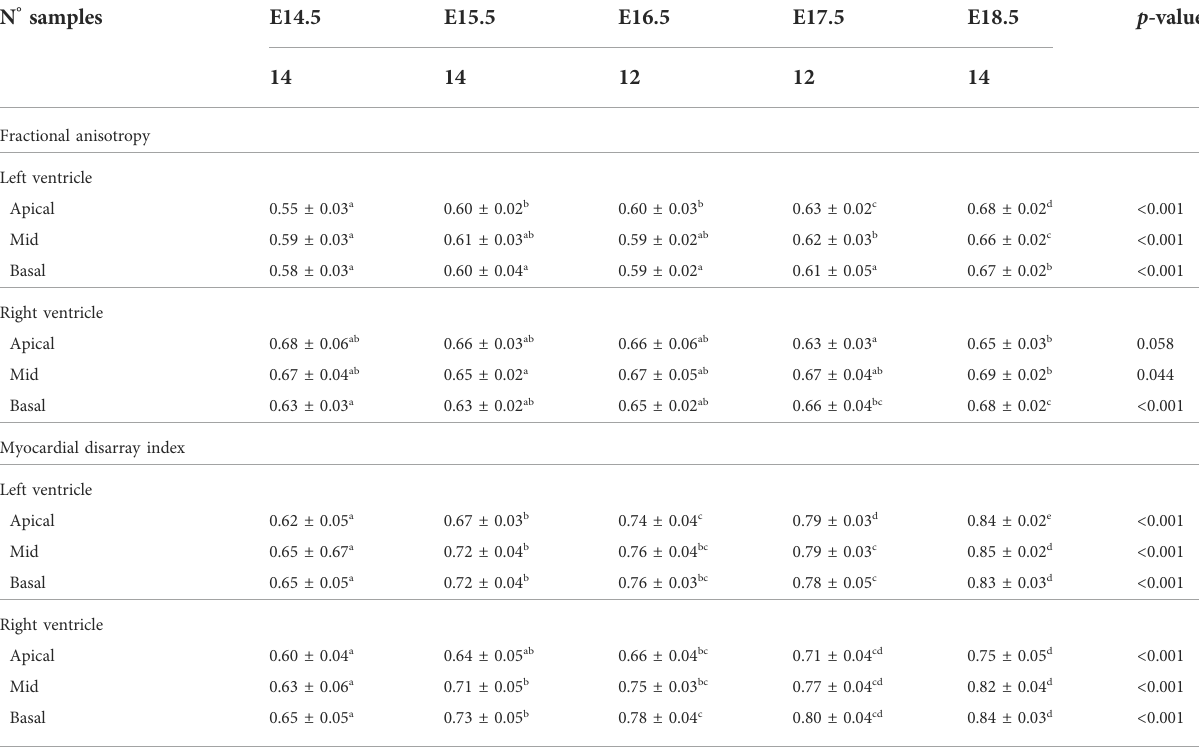
TABLE 5 Fractional anisotropy (FA) and myocardial disarray index (MDI) in the left (LV) and right ventricle (RV), quanti fi ed at apical, mid and basal levels, expressed as mean ± standard deviation. N °